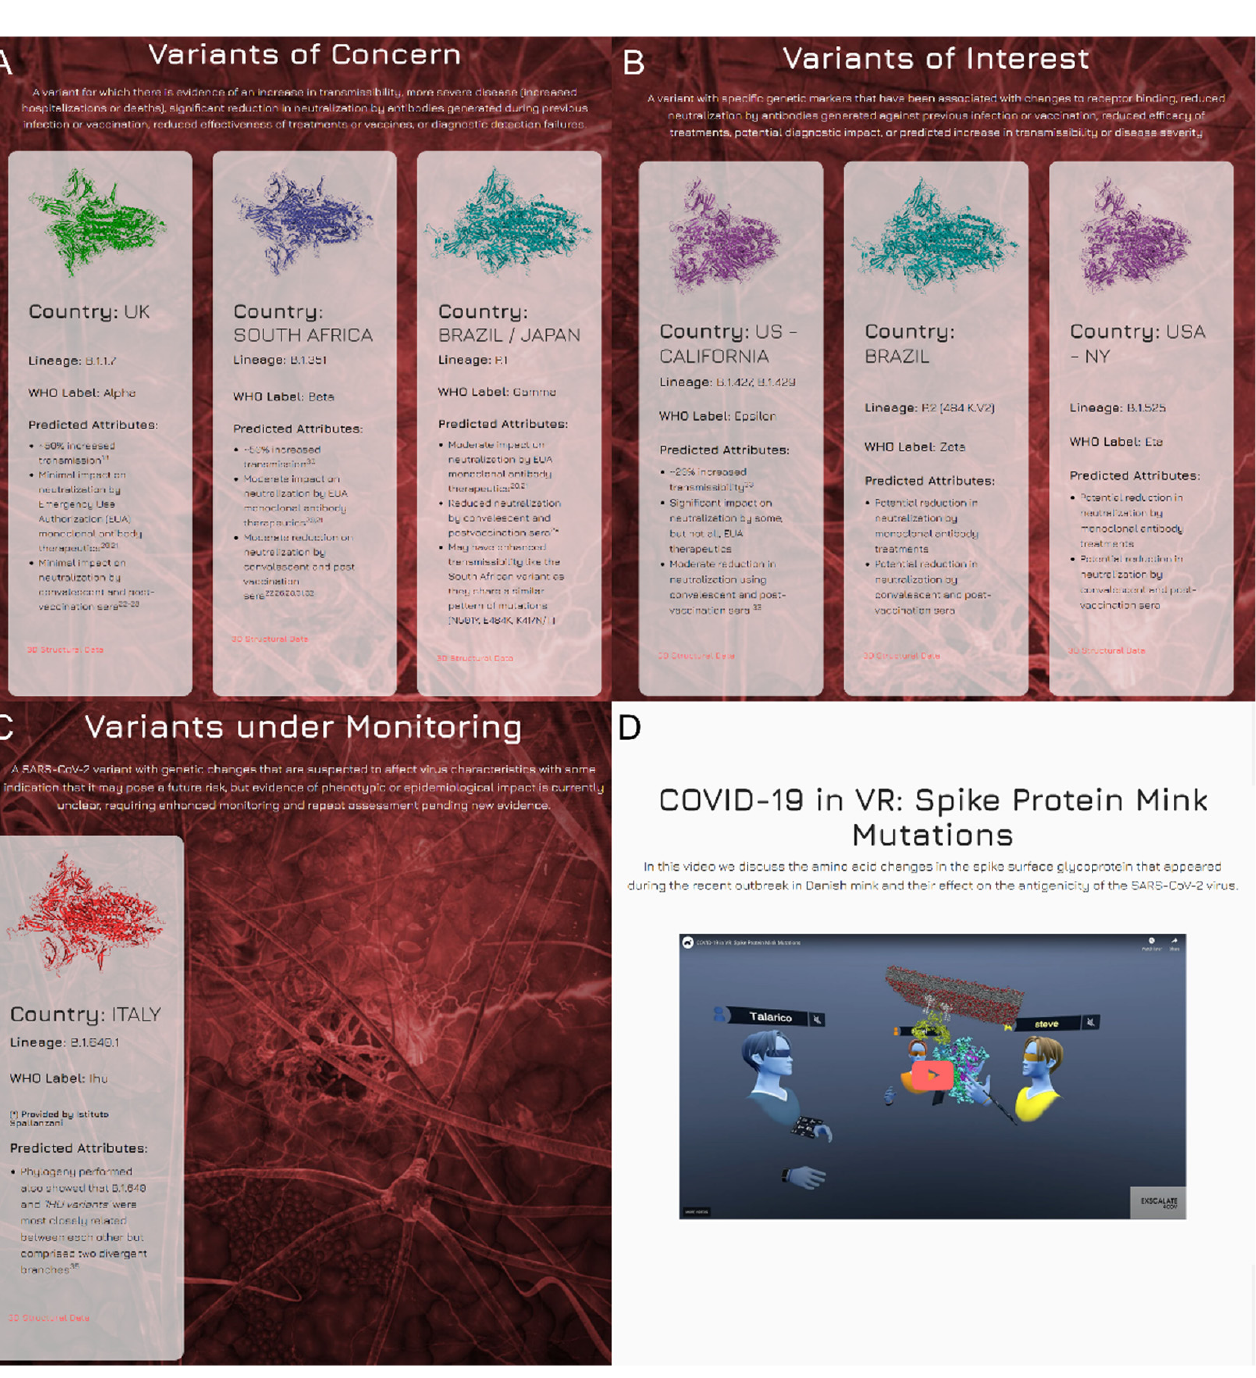
Figure 1. Snapshot of the upper portion of the Spike Mutants portal from where the 3D structure of the spike trimeric protein in glycosylated form and its corresponding MD trajectory 100 ns long can be freely downloaded.